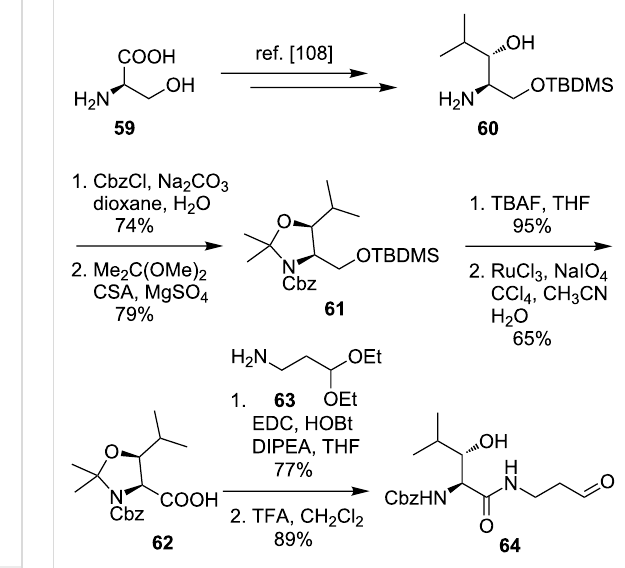
Scheme 8: Synthesis of a hydroxyleucine-derived aldehyde building block reported by Ducho et al. [107].